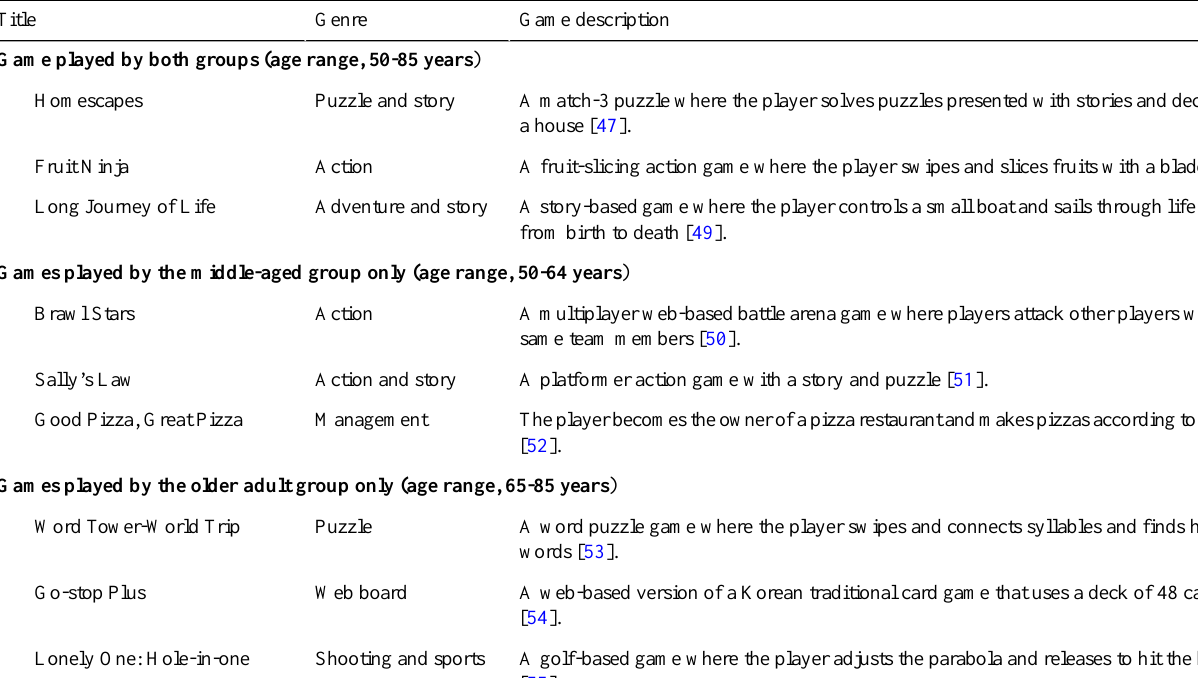
Table 3. Games played in the workshops.